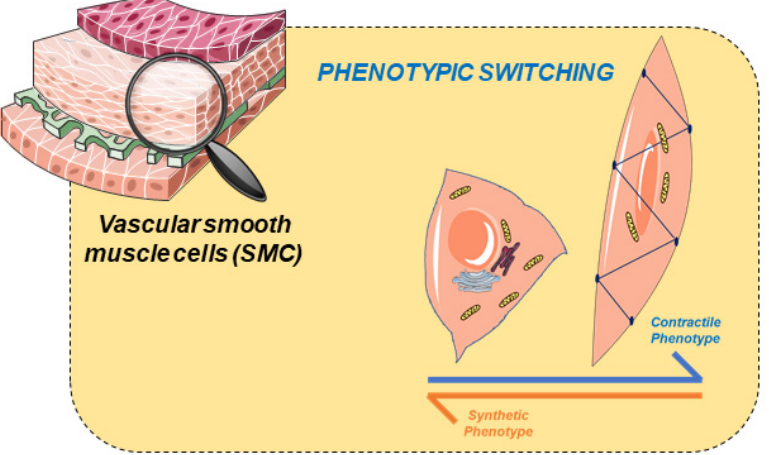
Figure 1. Schematic representation of the phenotypic switching in vascular smooth muscle cells.